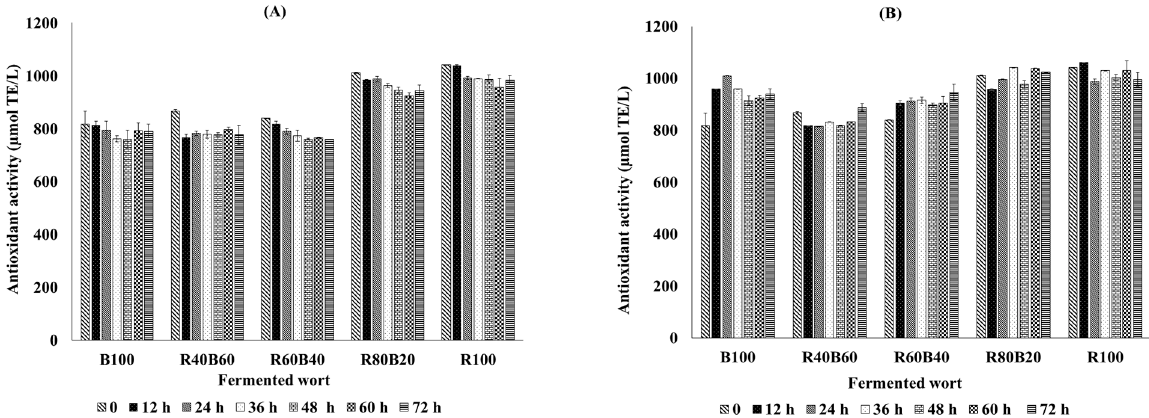
Figure 5. Changes in antioxidant activity via DPPH in fermented wort (B100, R40B60, R60B40, R80B20, and R100) by the two yeast strains BRY 97 ( S. cerevisiae ), POF − ( A ); and Belle Saison ( S. cerevisiae var. diastaticus ), POF + ( B ) .